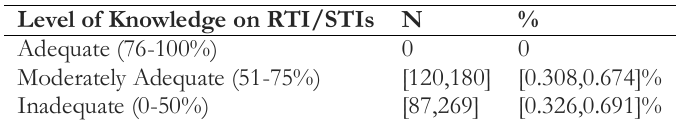
Table 3. Distribution of level of knowledge on RTI/STIs.